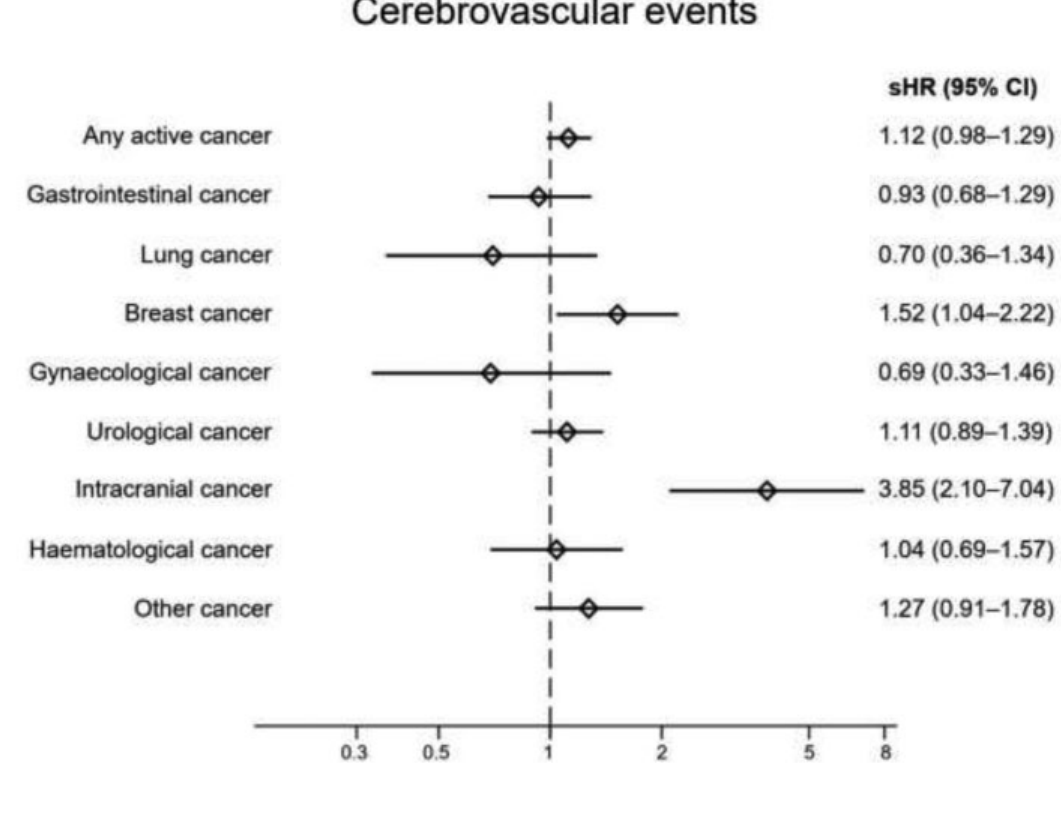
Fig. 2 Adjusted risks for cerebrovascular events during the year following OAC initiation in patients with AF: cancer versus noncancer patients, accounting for the competing risk of death. AF, atrial fi brillation; OAC, oral anticoagulant.